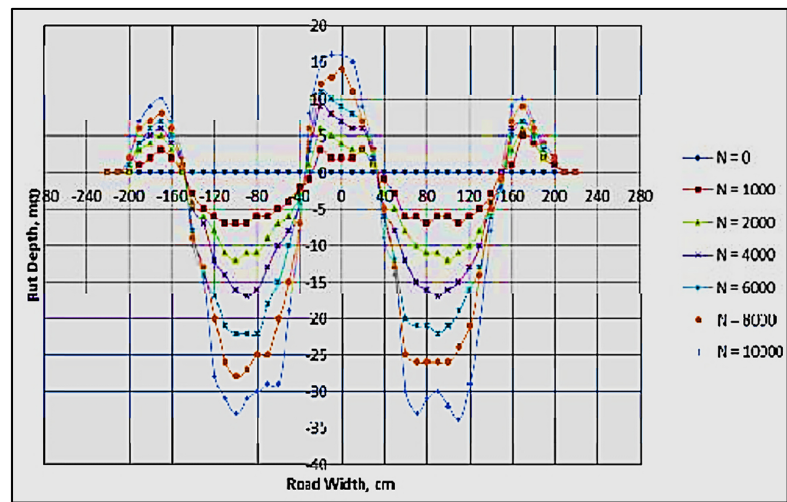
Figure 13: Rutting depth at interface